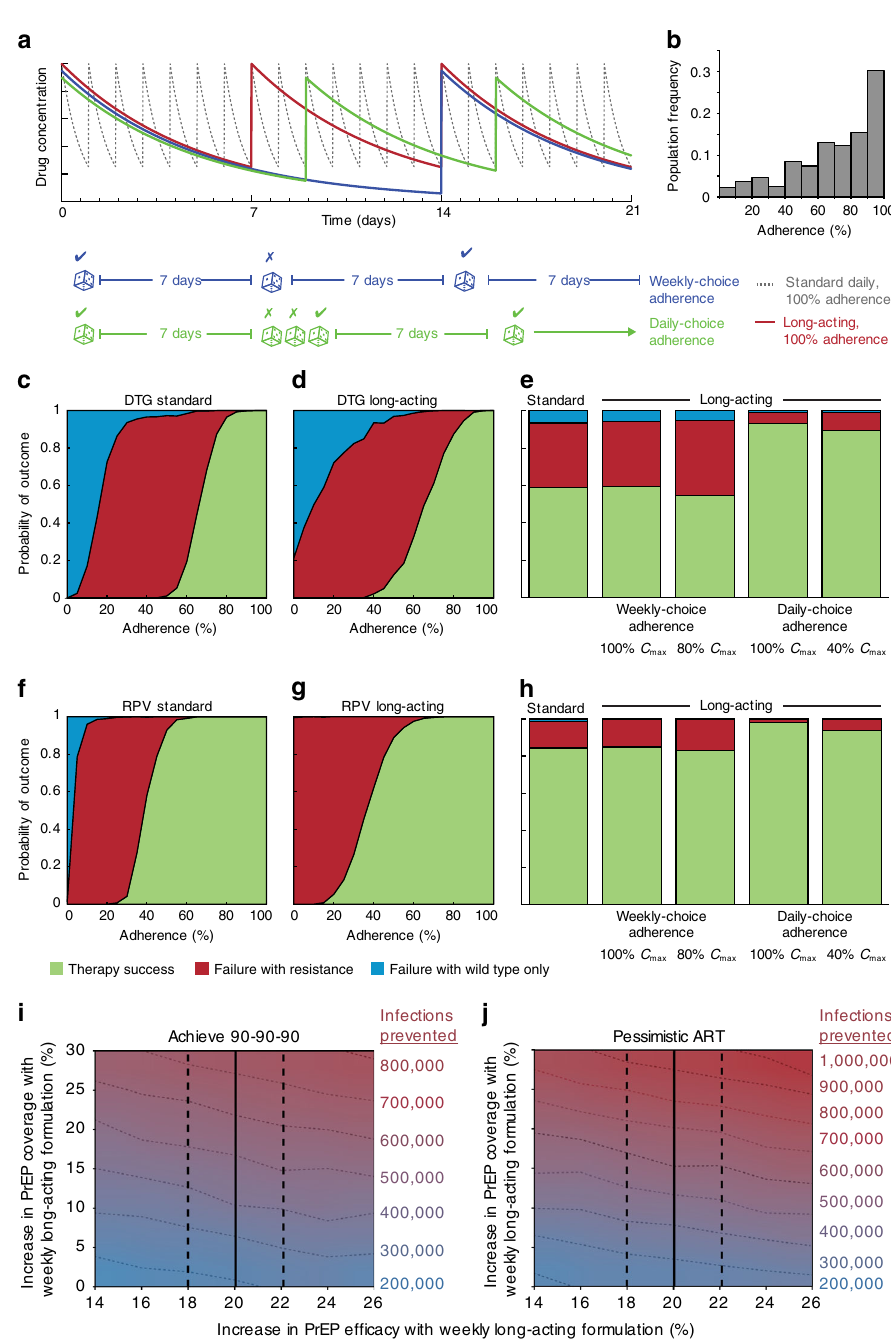
Fig. 5 Mathematical modelling of HIV treatment outcomes using long-acting antiretrovirals. a – h Viral dynamics modelling of HIV growth and evolution within individual patients. We consider a hypothetical weekly formulation, with identical peak concentration and 7-fold longer half-life a . Adherence patterns described in more detail in text and Supplementary Information. Patients are initially fully virologically-suppressed and failure is de fi ned as two consecutive monthly viral load measurements > 200 c/mL in the year-long follow-up period. The height of the shaded area indicates the probability of outcome. Predicted patient outcomes versus adherence level (% of scheduled doses taken) for existing daily formulation of DTG ( c ) and RPV ( f ), and for long-acting versions, ( d , g ). Predicted outcomes for DTG ( e ) and RPV ( h ): a cohort of patients with a distribution of adherence levels taken from empirical data 11 , average adherence ~70% ( b ). C max is the peak drug level and is determined by the dosage size and absorption. 100% means that this value is the same for the hypothetical long-acting formulation as the existing one. i – j Epidemiological modelling of the impact of using oral long-acting antiretrovirals for PrEP in South Africa. The contours show the cumulative number of additional infections prevented (in thousands) by switching from daily to weekly oral PrEP formulation in South Africa by 2037. The x -axis depicts the supposed increase in ef fi cacy (de fi ned as reduction in per-exposure probability of infection), compared to a baseline ef fi cacy of 50%. Solid lines indicating the plausible estimates (con fi dence intervals depicted as dashed lines) from meta- analyses respectively. The y -axis shows assumed increase in coverage (% of high-risk population receiving PrEP) assuming a baseline coverage of 30%. “ Pessimistic ART ” assumes current rates of ART use for treatment ( i ) while “ Achieve 90-90-90 ” assumes increased rates ( j